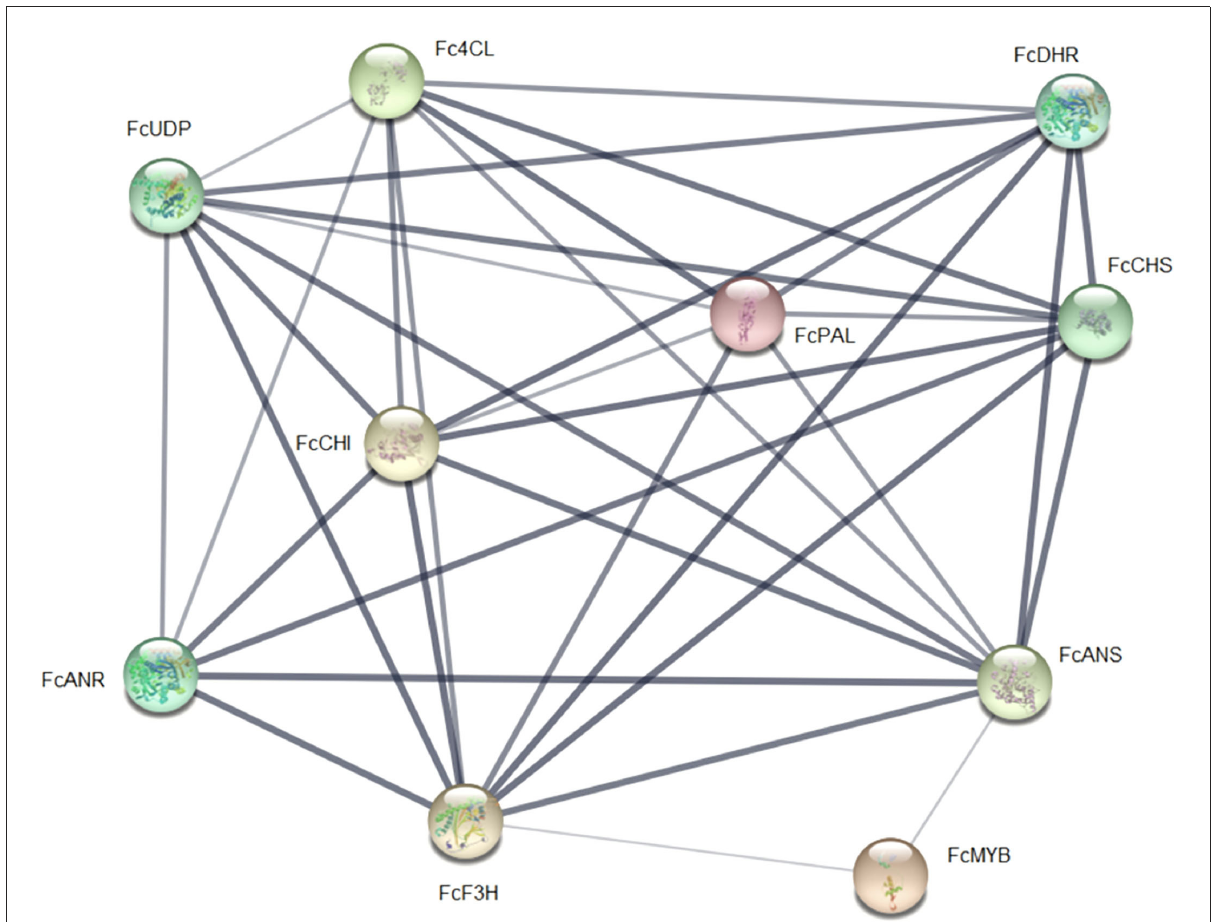
FIGURE9 Network of gene interactions among genes differentially expressed from the phenylpropanoid and flavonoid pathways and FcMYB using STRING. Each node represents the interaction described in the literature between proteins from the phenylpropanoid and flavonoid pathways and FcMYB1, whose transcripts are differentially expressed in the